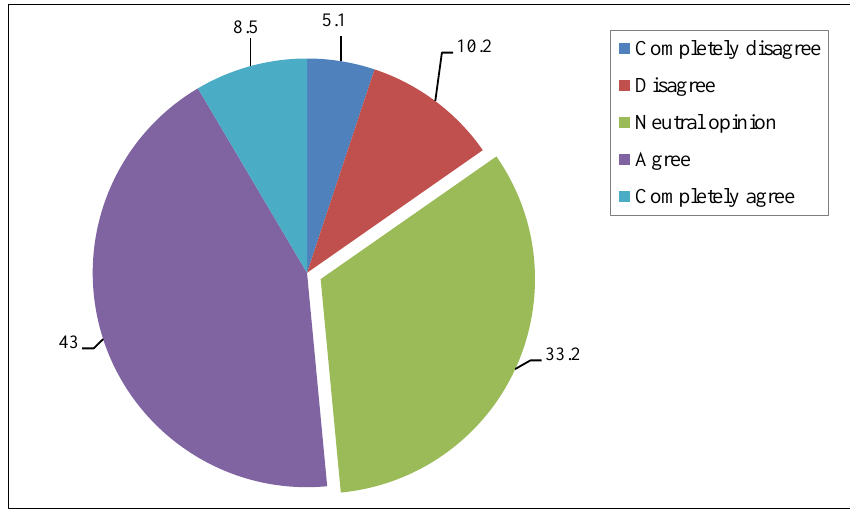
Figure 2. Enterprises enhancing the business management capacity